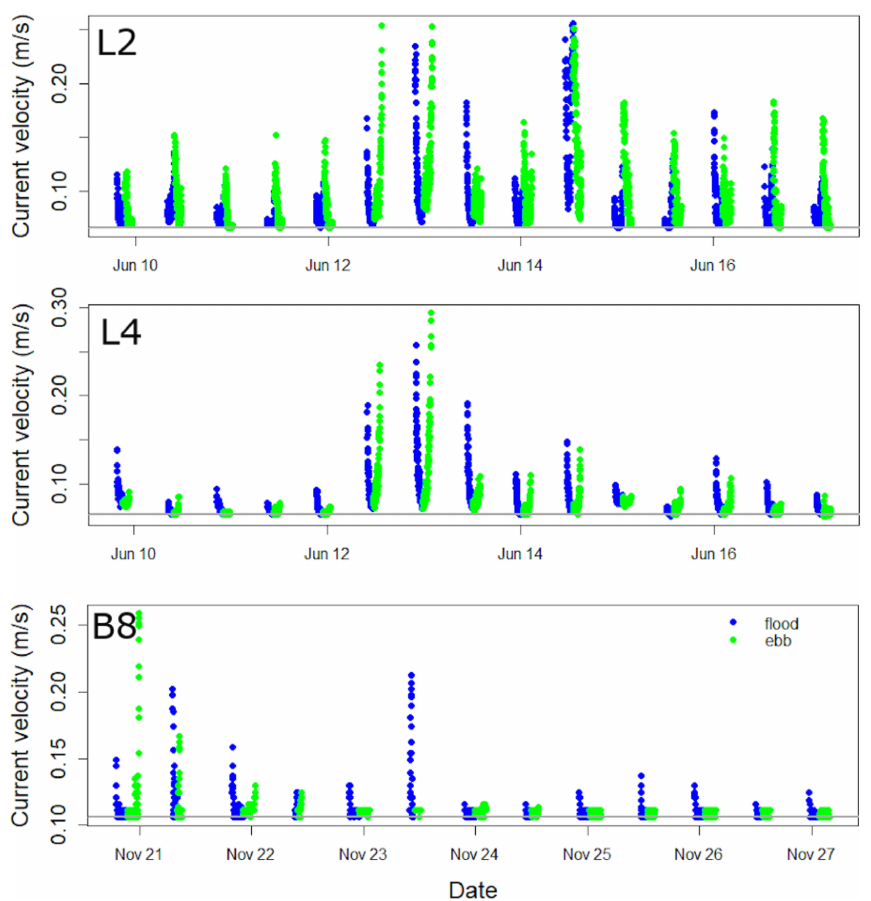
Figure 4. Examples of predicted current velocities during predicted inundation events for L2, L4, and B8 using the LDA (Fig. 3a) for inundation and regression analysis for velocity predictions (Fig. 3b). Colours denote the first and second half of the inundation time period (approx. flood and ebb tide), and the grey line indicates the detection threshold (i.e. Bay of Fundy (L2, L3) = 0.06ms − 1 , North Sumatra (B8) = 0.106ms − 1 ; see Fig.